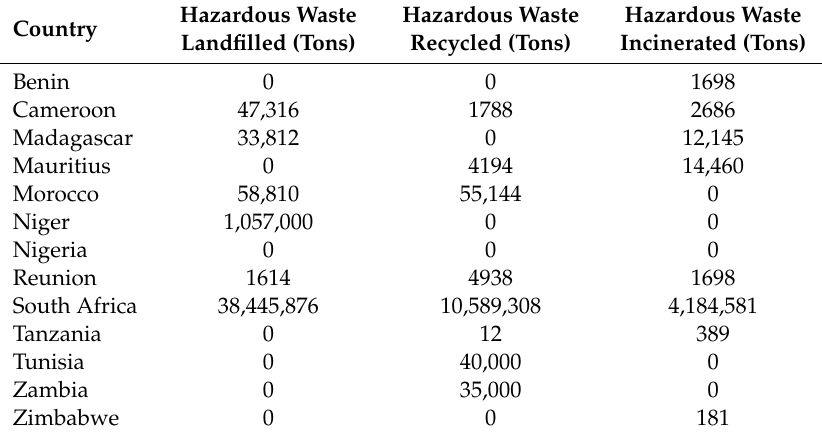
Table 6. Summary of Hazardous Waste Landfilled, Recycled, and Incinerated in Some Selected African Countries [2]. Hazardous Waste Hazardous Waste Hazardous Waste Country Landfilled (Tons) Recycled (Tons) Incinerated (Tons) Benin 0 0 1698 47,316